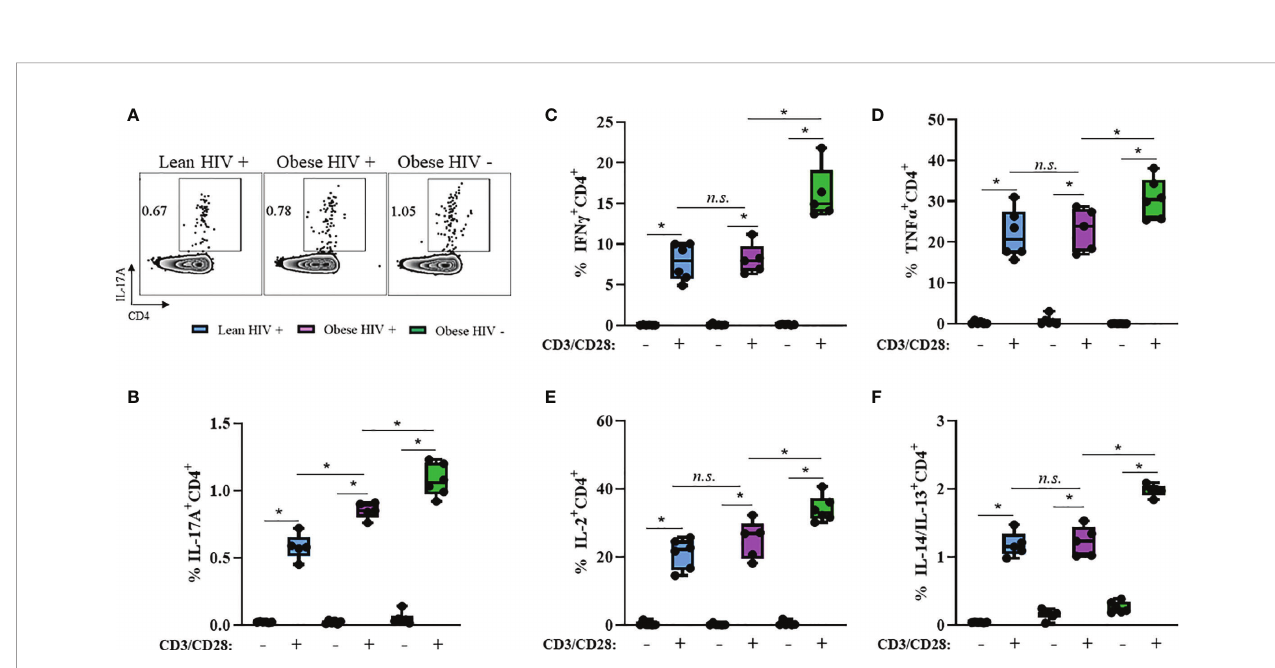
FIGURE 1 | Ki67 expression is increased in CD4 + T cells from obese PLWH compared to lean PLWH. PBMCs from obese and lean PLWH, as well as HIV negative obese controls, were stimulated with anti-CD3/CD28/CD49d for 2 days. (A) Representative fl ow gating of Ki67+CD4+ T cells and (B) Quanti fi cation of the percentage of Ki67 + CD4 + T cells. Mann-Whitney tests were used to compare obese and lean PLWH, or obese PLWH and obese HIV negative controls. n = 5-6 persons per group. * p < 0.05 was considered statistically signi fi cant. Data shows one representative experiment repeated three times. n.s . means not statistically signi fi